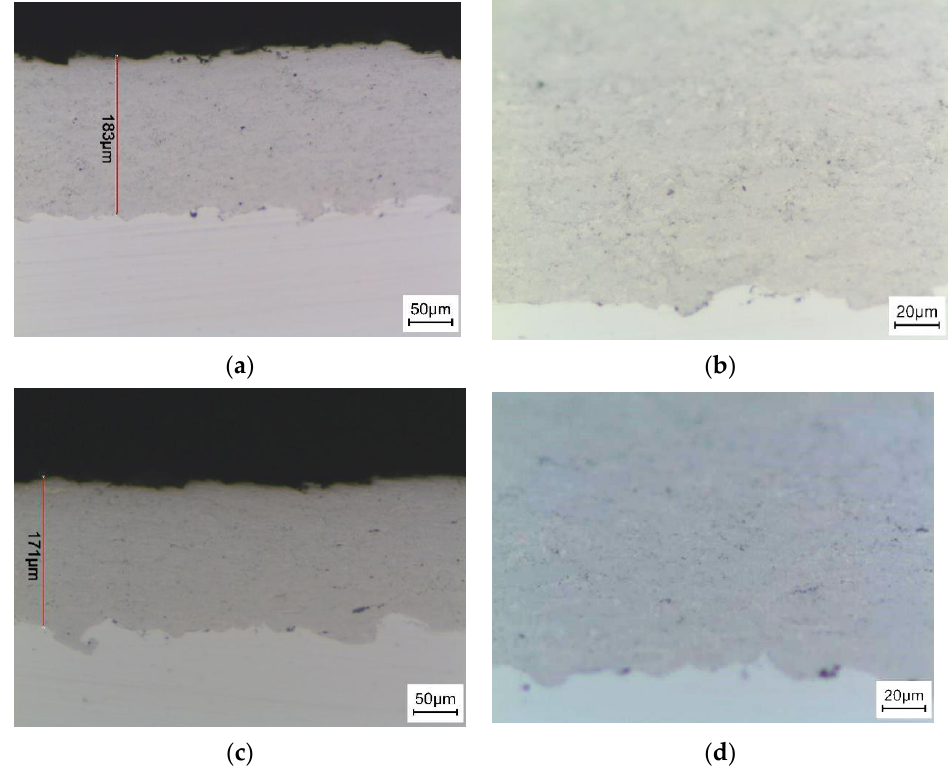
Figure 4. Metallographic micrograph of two coating cross section: low magnification of ( a ) WC- 10Co-4Cr coating and ( c ) WC-10Co-4Cr+CeO 2 coating; high magnification of ( b ) WC-10Co-4Cr coating and ( d ) WC-10Co-4Cr+CeO 2